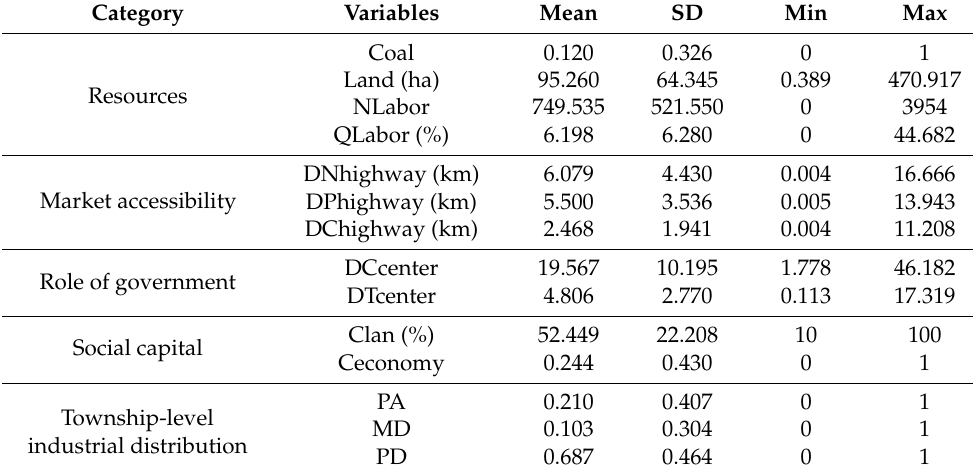
Table 3. Descriptive statistics (villages, n = 806 for all